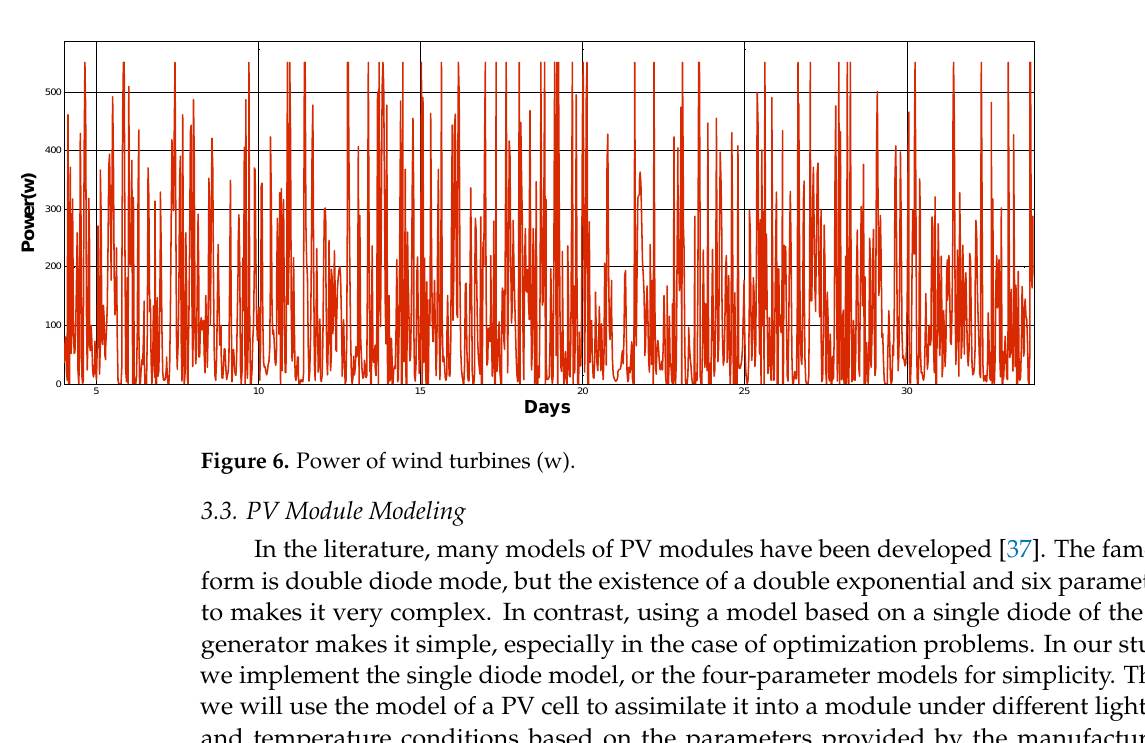
Table 1. Characteristics of the PV module.